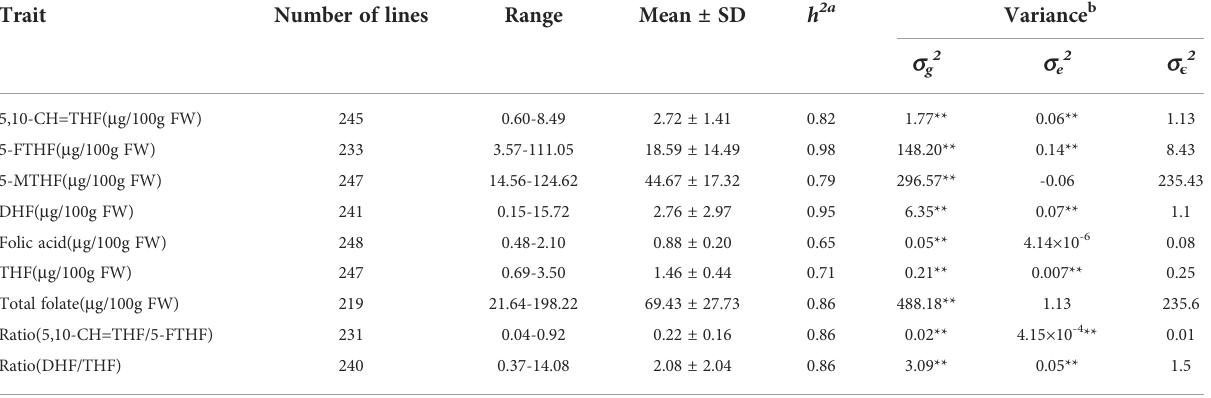
TABLE 1 Statistical summary, broad-sense heritability and variances of folates in the sweet corn population.